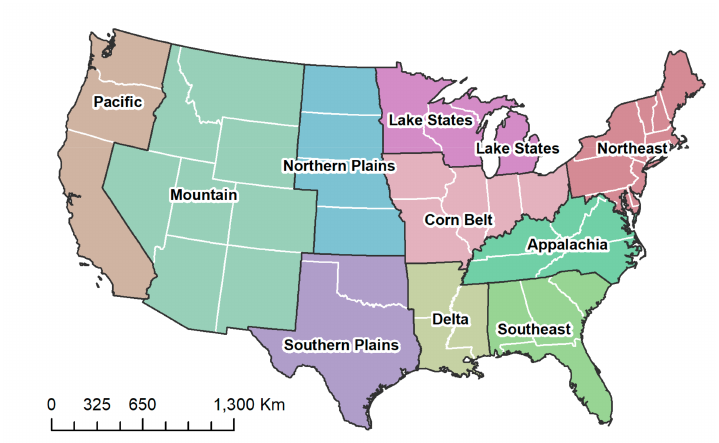
Figure 2. Ten agricultural production regions used in this study.